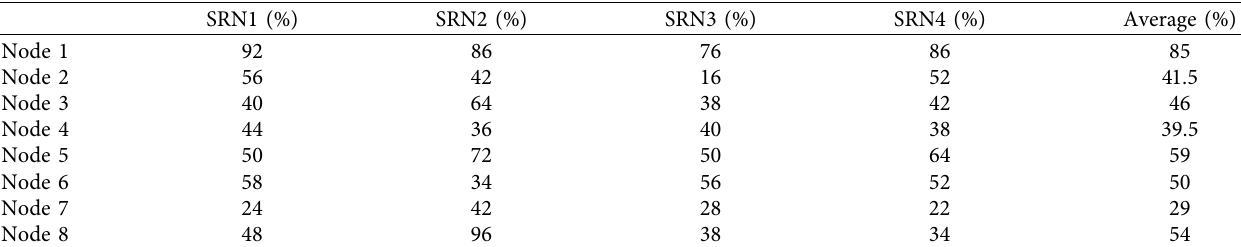
Figure 5: HPE of eight nodes for four types of SRN. (a) Node 1. (b) Node 2. (c) Node 3. (d) Node 4. (e) Node 5. (f) Node 6. (g) Node 7. (h) Node 8. Table 1: HDE recognition rates for four types of